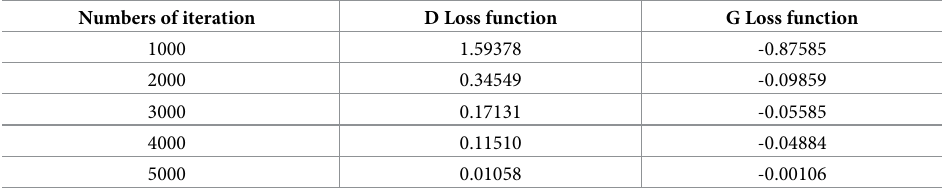
Table 4. Changes in the loss function during iteration.